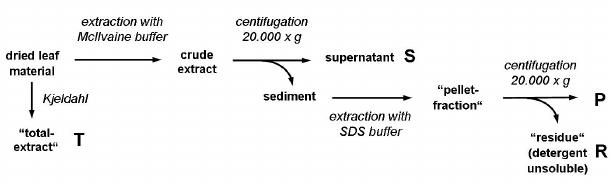
Fig. 2: Scheme of protein sample preparation. Protein determination -